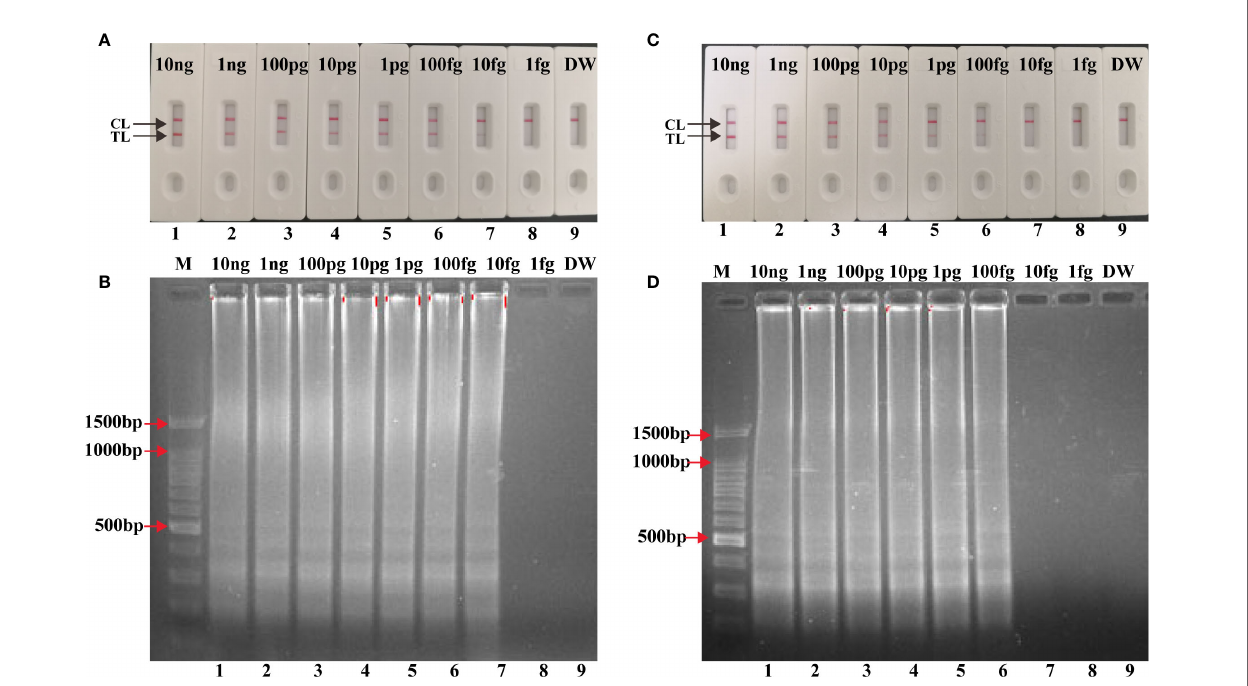
FIGURE 4 | Analytical Sensitivity of singlex LAMP-LFB assay. Serial dilutions (10 ng, 1 ng, 100 pg, 10 pg, 1 pg, 100 fg, 10 fg, 1 fg) of genomic DNA of H37Rv were used for sensitivity determination of IS 6110 -LAMP (A, B) and IS 1081 -LAMP (C, D) assay. (A, C) Visual results of LFB for LAMP assay. (B, D) 1.5% agarose gel electrophoresis applied for LAMP products. Biosensors/lanes 1-9: H37Rv genomic DNA (10 ng, 1 ng, 100 pg, 10 pg, 1 pg, 100 fg, 10 fg, 1 fg),